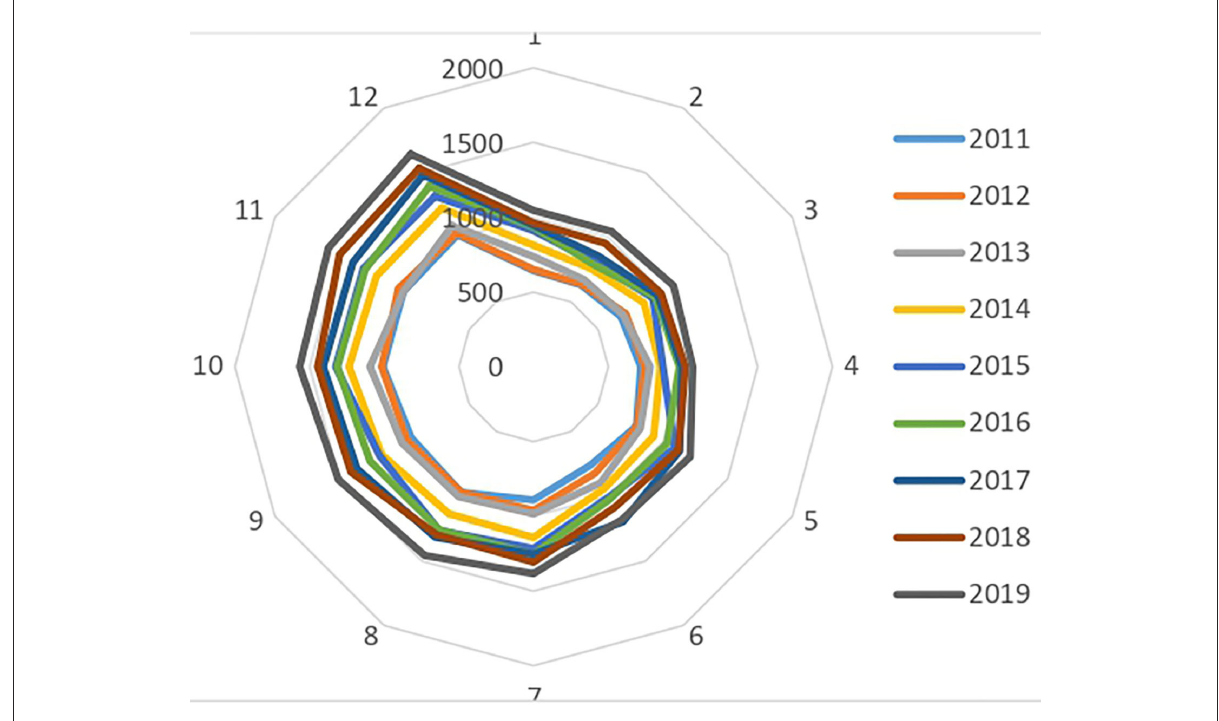
FIGURE5 Children and adolescents treated with MPH by birth month between 2011 and